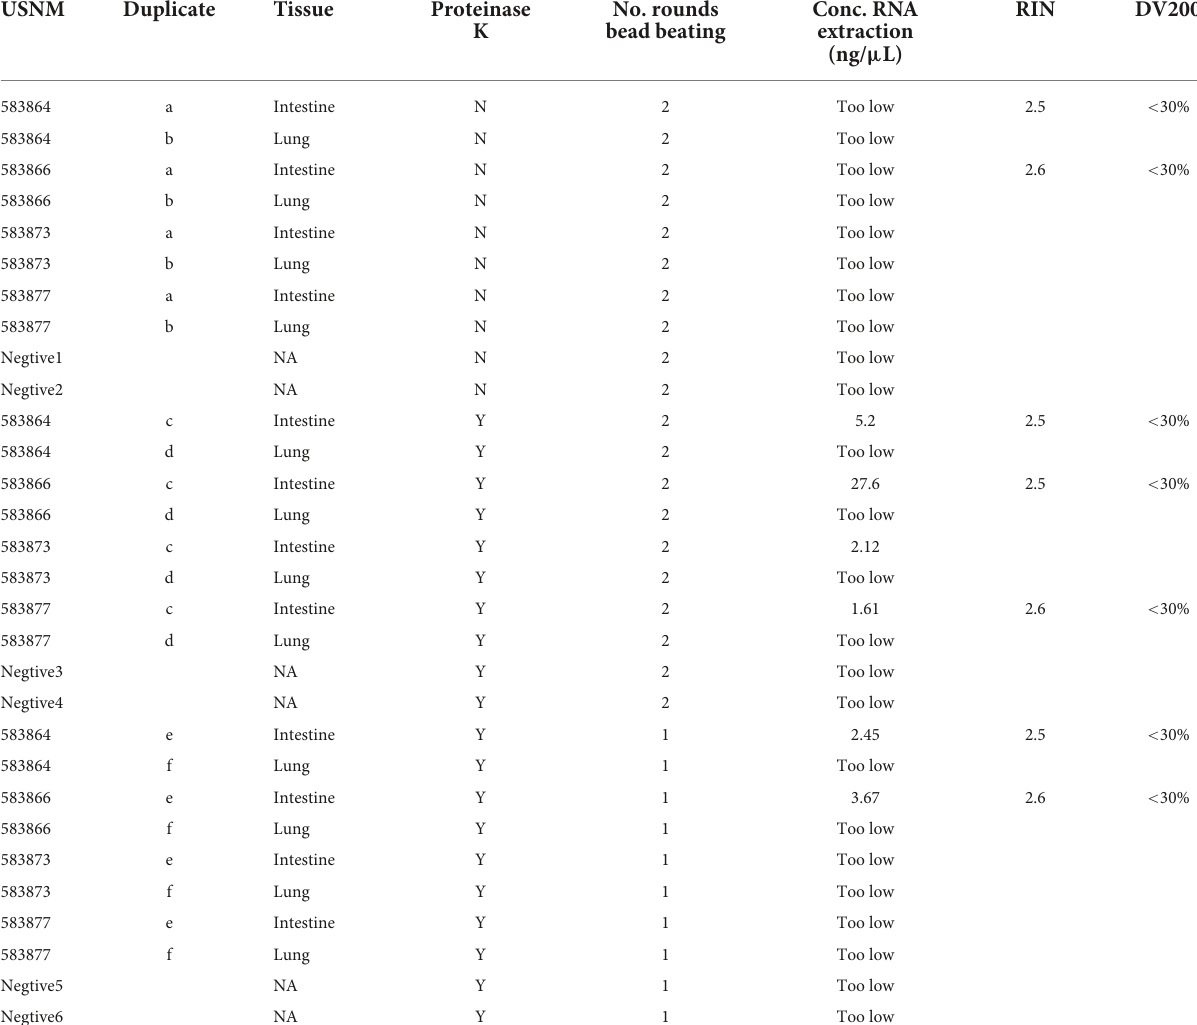
TABLE 1 Optimization of RNA extraction from formalin-fixed tissues.